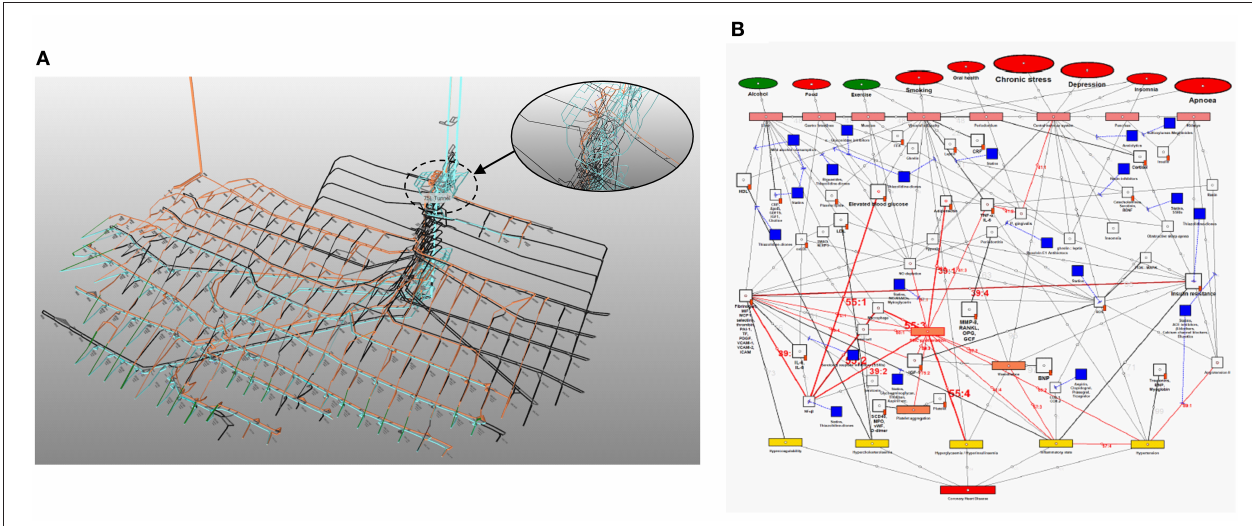
FIGURE 13 | Schematics of typical simulation networks for (A) engineering and (B) CHD (23). (A) provides a small section of computer model of a relatively complex deep mine. (B) shows the initial computer model ( 23) developed from the existing CHD model in Figure 1 (23) using the simulation software developed for (A) . The CHD computer model includes all the known interactions for health factors, measured elements (salient biomarkers) and controls ( pharmaceutical interventions). Remember it is the measured biomarkers that individualize a